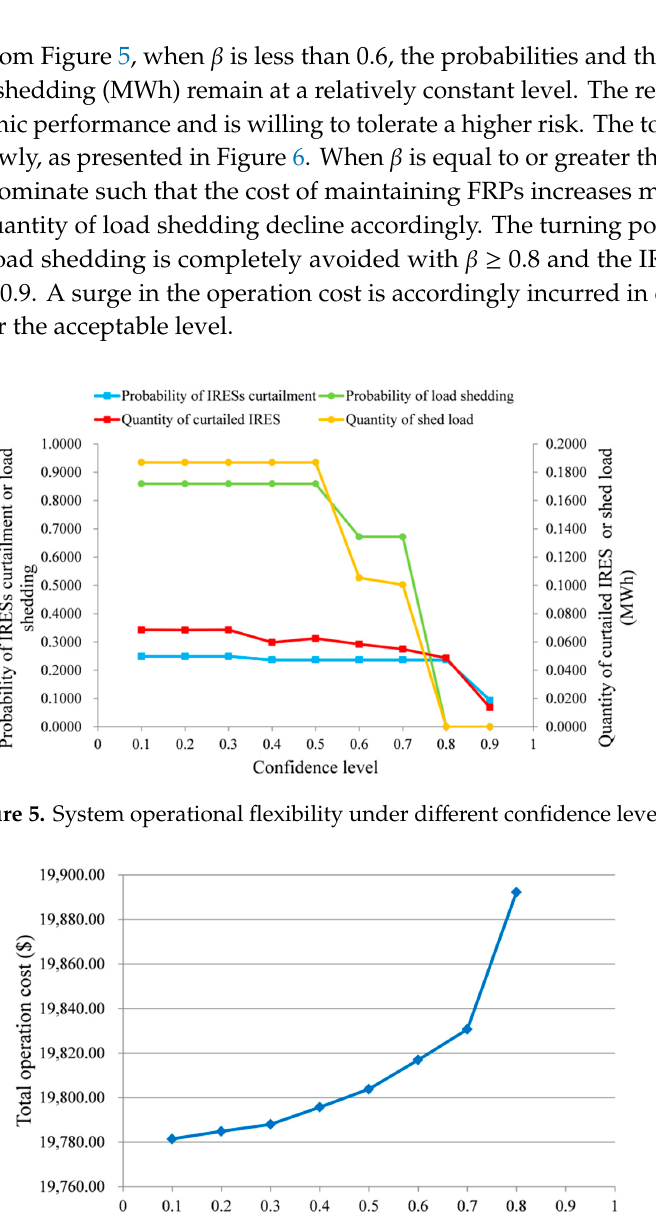
Figure 6. Total operation cost under different confidence level.